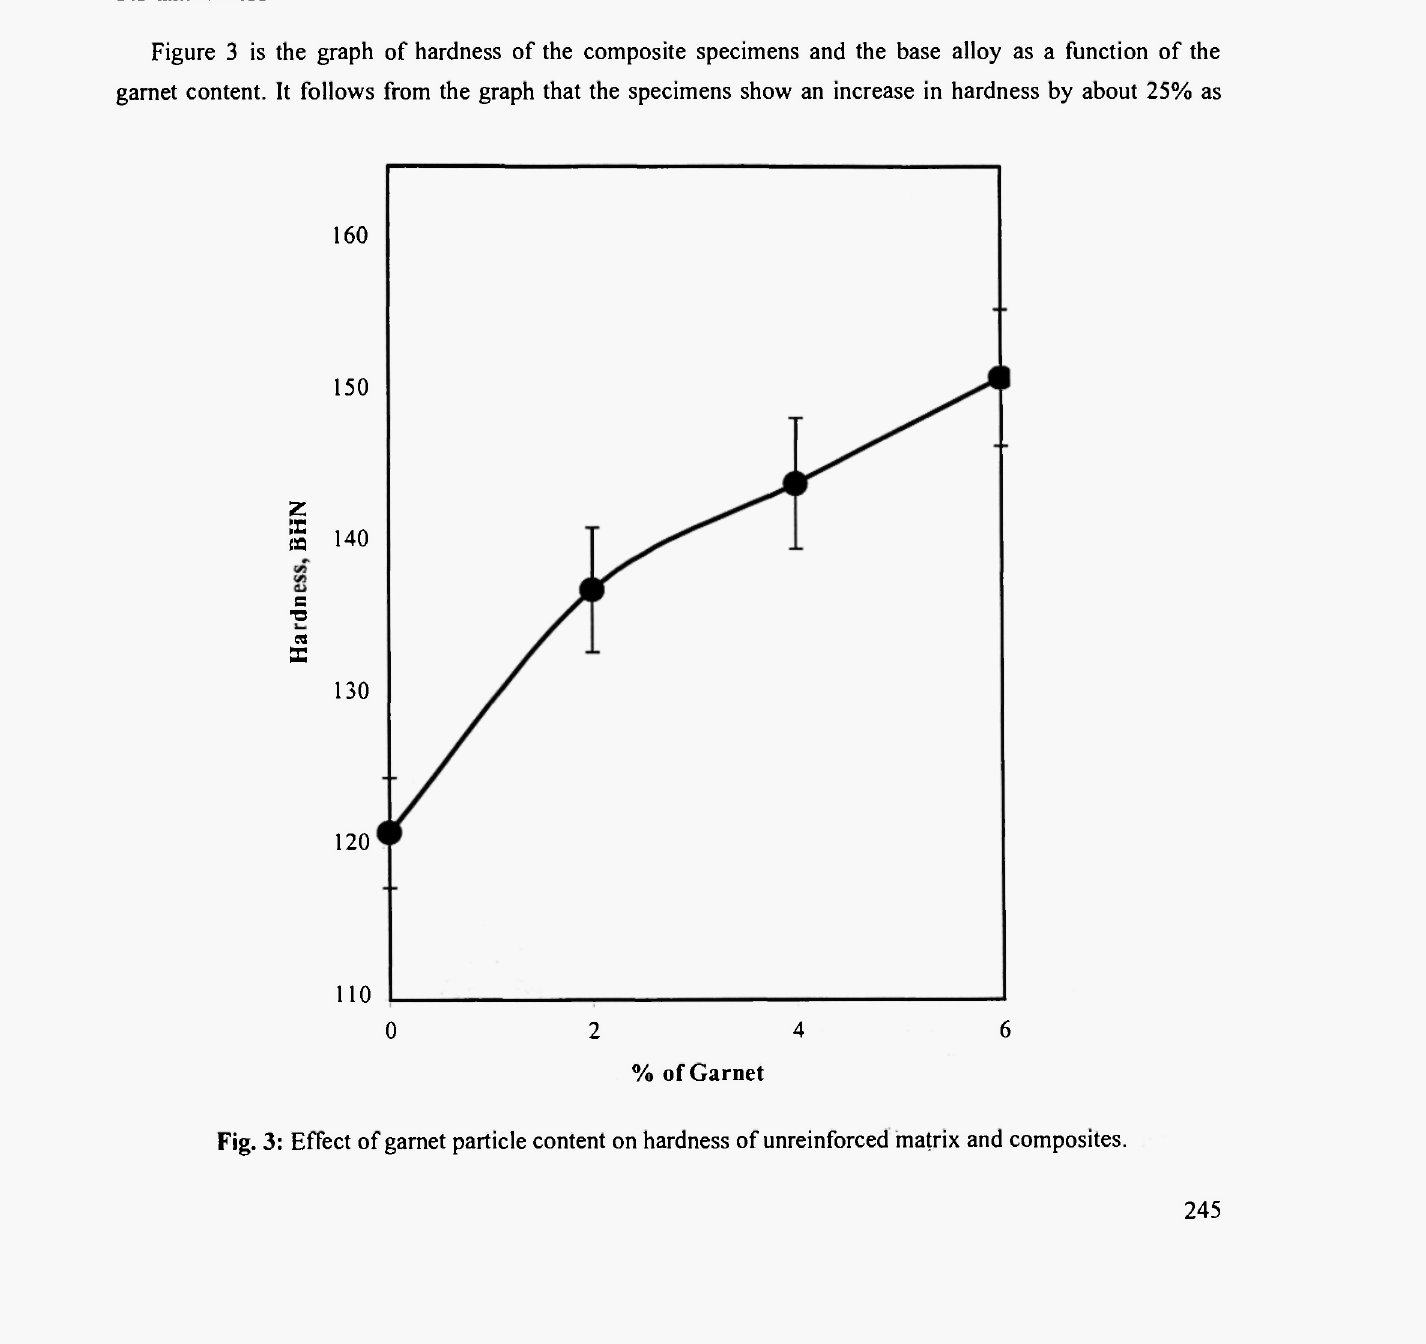
Fig. 3: Effect of garnet particle content on hardness of unreinforced matrix and